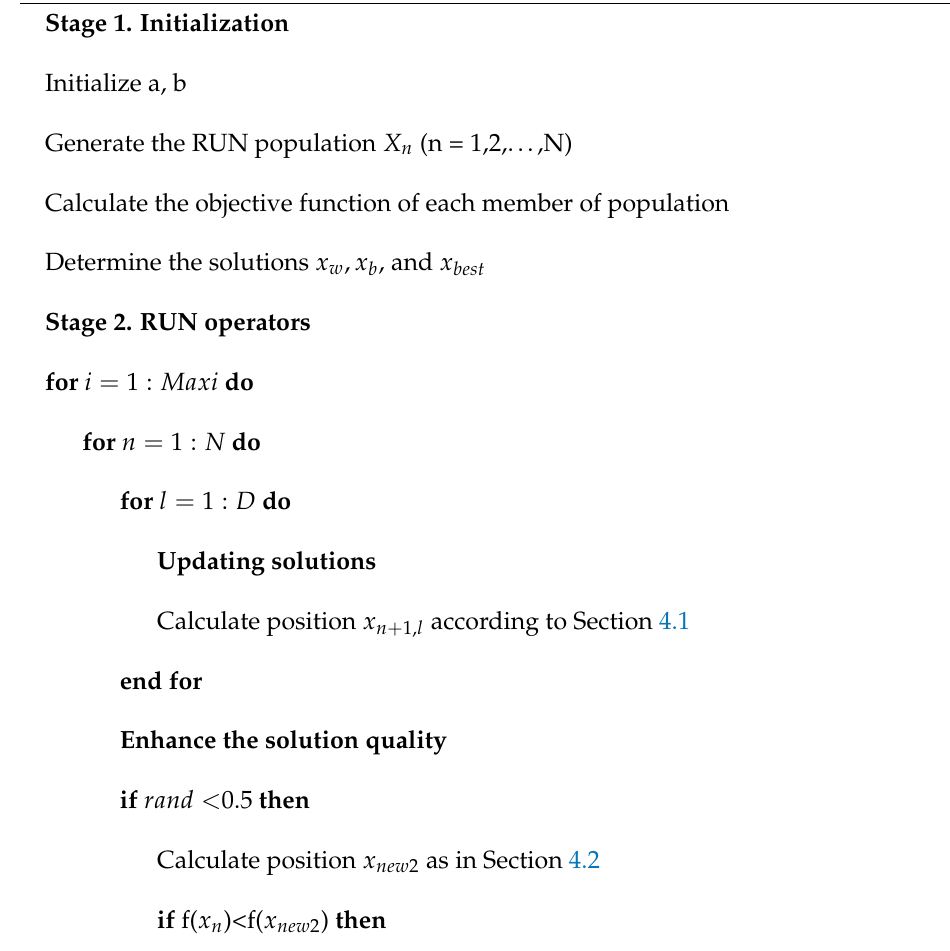
Algorithm 4 The pseudo-code of